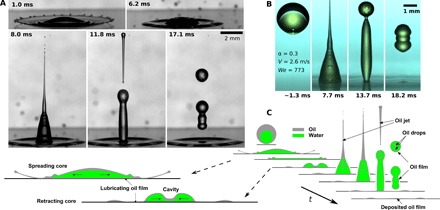
Impact of a compound drop of water with volume fraction α = 0.3 on a hydrophilic surface.(A) Black and white image sequence of an impact from an impact height of h = 0.33 m (impact velocity V = 2.4 m/s, We = 659). (B) Color image sequence for h = 0.39 m (We = 772). The water was dyed through addition of a fluorescein salt to distinguish it from the oil. Images were postprocessed to remove spots due to dust on the sensor. (C) Schematic vertical cross sections of an impacting compound drop, illustrating horizontal splashing of oil, the formation and collapse of a cavity, the ejection of a vertical oil jet, the entrapment of oil in the core, and rebound of the core.